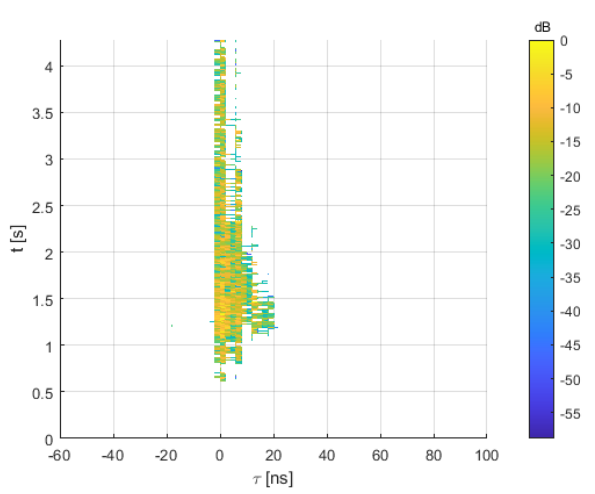
Figure 21. Measured PDPs shifted to align the main component.